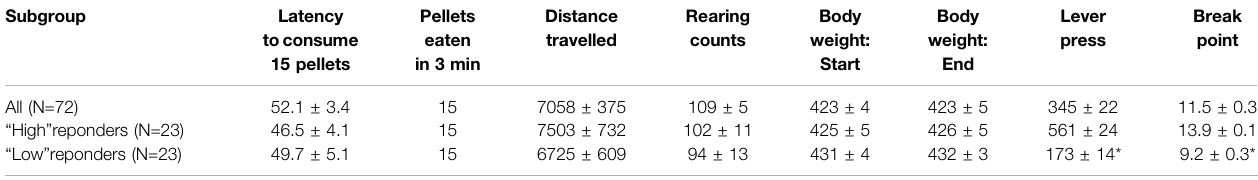
TABLE 1| Comparison between “ high ” and “ low ” PRresponders (N (cid:1) 23 rats per tertile; N (cid:1) 72 rats total, i.e. “ All ” ) on ameasure offreefeeding, open fi eld activity and body weight. Measures of freefeeding wasthe latency toconsume 15 × 45 mg food pellets, and thenumber of45 mg pellets eaten in a3 min freefeedingsession (maximum number (cid:1) 15 which approximated to the amount offood pellets earned in a progressive ratio test session. Open fi eld activity wasmeasured as the distance traveled and the number of rears counted in a 60 min test. Body weights were also compared between the start and completion of testing. There were no differences between “ high ” and “ low ” PR responders on any of these measures, despite robust differences in no. lever presses and break point. * p < 0.01 vs. “ High ” responders. Subgroup